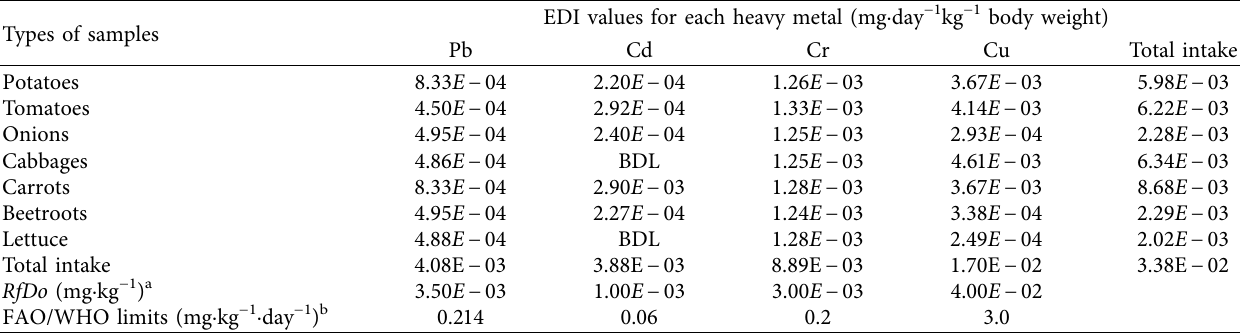
Table 7: Te estimated daily intake (EDI) and total intake values of heavy metals through the consumption of vegetables. Types of samples